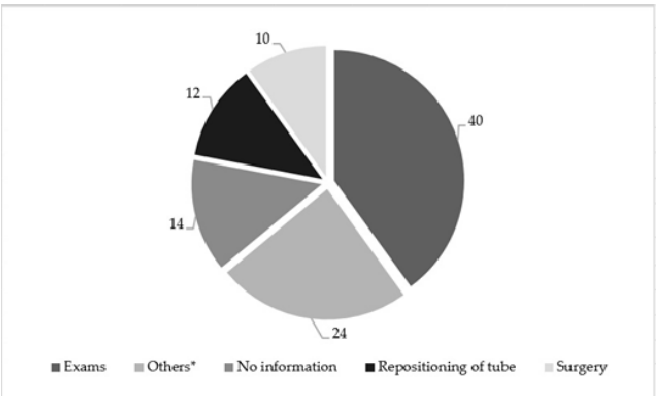
Figure 2. Factors leading to fasting for ≥ 24 h (%) during enteral nutritional therapy administration, N = 101. * Phonoaudiologist assessment; lowering level of consciousness; dose noradrenaline; hemodynamic instability; drainage of feeding tube; methylene blue test.